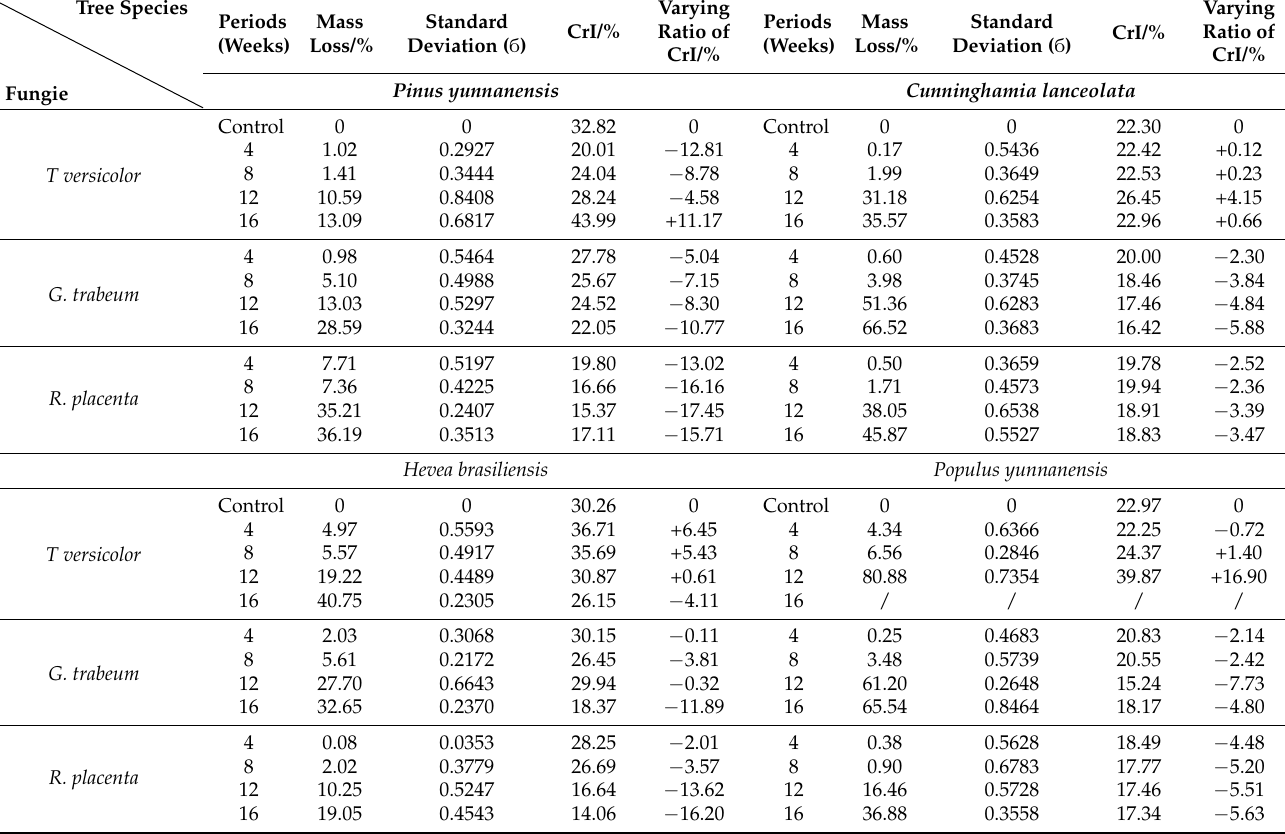
Table 1. Mass conversions and crystallinities of wood samples at different